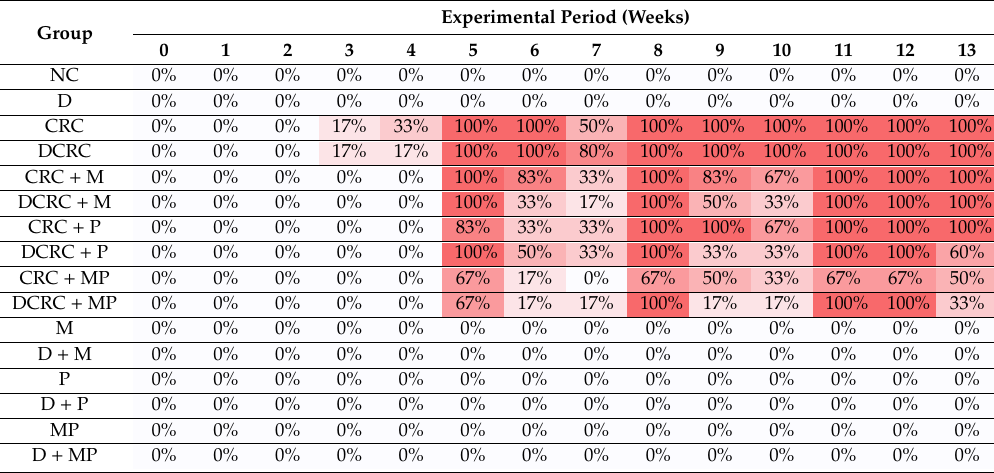
Table 1. E ff ects of Metformin and Probiotics on Fecal Occult Blood (FOB). FOB was Assessed Weekly; Percentages were Obtained by Calculating the Number of “Positive” Animals in Each Group. A Color Scale Ranging from Strong to Faint Red is Used, whereby the Shade of the Red Color Represents the Value of the